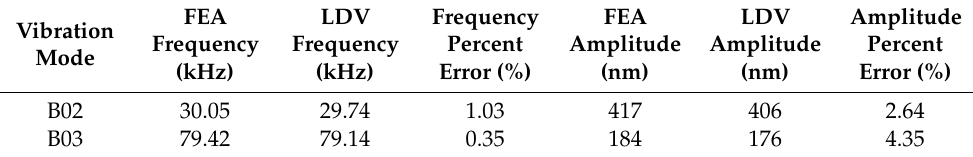
Table 3. Simulation and test results for the PZT thick film micro